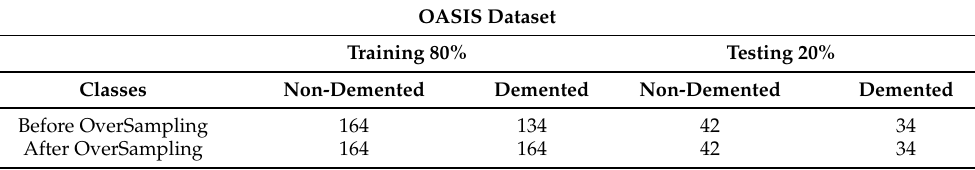
Table 4. OASIS dataset balancing before and after application of the SMOTE